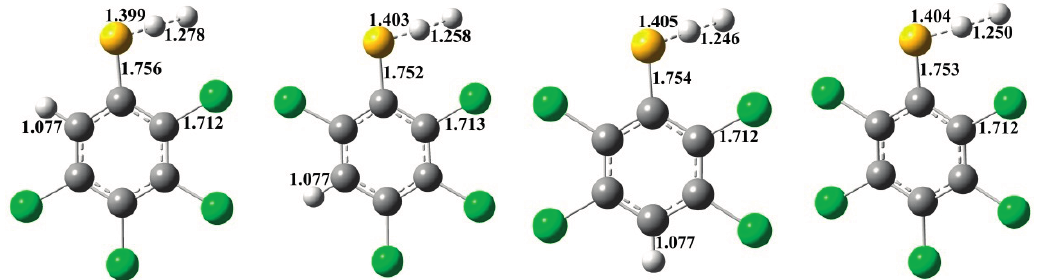
Figure 2. MPWB1K/6-31+G(d,p) optimized geometries for the transition states of the thiophenoxyl-hydrogen abstraction from CTPs by H. Distances are in angstroms. Gray sphere, C; White sphere, H; Yellow sphere, S; Green sphere, Cl. (For interpretation of